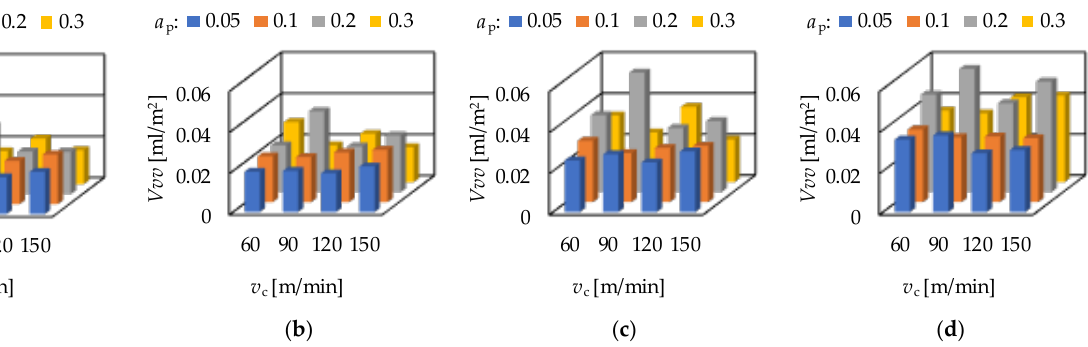
Figure 6. The measured valley void volume ( Vvv ) values for hard turning by applying ( a ) f = 0.05 mm/rev, ( b ) f = 0.1 mm = rev, ( c ) f = 0.15 mm/rev, ( d ) f = 0.2 mm/rev. The maximum peak height ( Sp ) is in connection with the wear resistance of a surface, while the maximum valley depth ( Sv ) is in connection with the fluid-retention ability. In hard turning the feed rate has a significant impact on these parameters. Both the Sp and the Sv values increase with the feed rate. Increasing average Sp and Sv values can be ob- served when the order of the depth-of-cut is: 0.05; 0.1; 0.3; 0.2 mm on the feed rates 0.05; 0.1 and 0.15 mm/rev. At the feed rate 0.2 mm/rev the order is: 0.1; 0.05; 0.3; 0.2 mm. The cutting speed has no clear effect on the Sp and Sv values. Concerning the feed rate, the Sp and Sv values increase with the feed rate, which is valid not only for the averages. The Sp and the Sv values for hard turning are demonstrated in Figures 7 and 8, respectively.